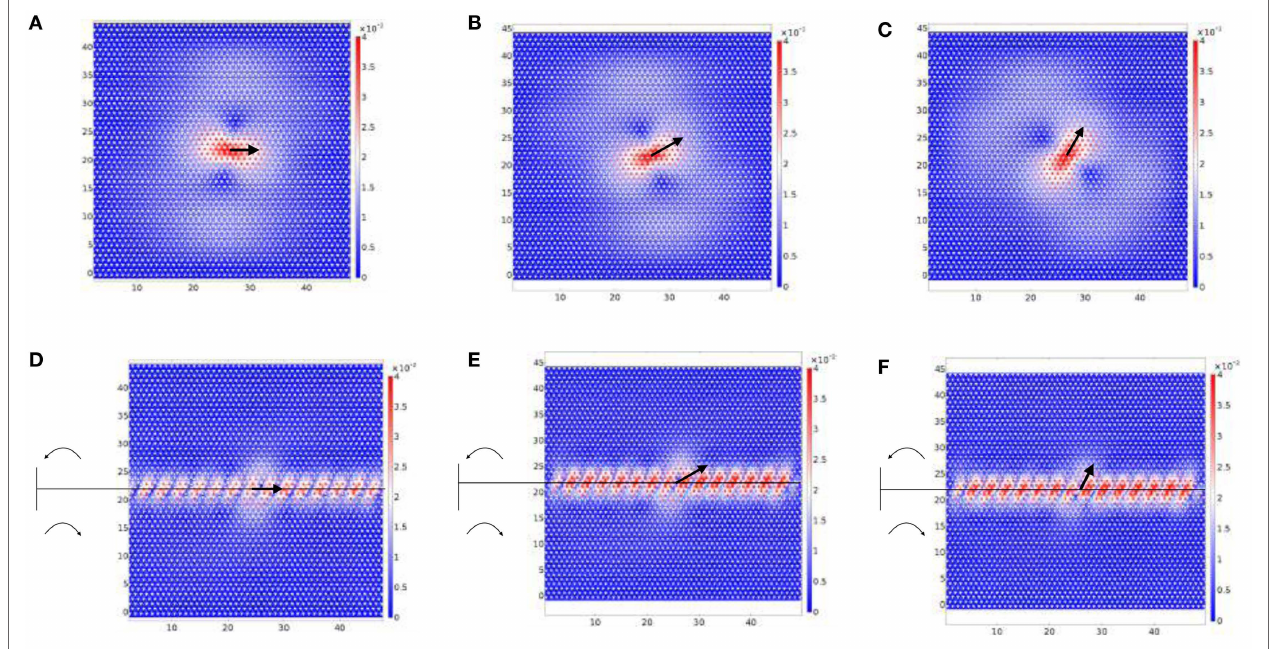
FIGURE 4 | Panels (A–C) are the responses of a homogeneous TLR to a harmonic force of amplitude F = 0.1N and frequency ω = π rad/s applied to a TL nodal point. The point loads (see black arrows) form an angle of 0, π /6, and π /3, respectively, with respect to the horizontal axis. Panels (D–F) are the responses of a non-homogeneous TLR to harmonic forces identical to those considered in panels (A–C) , respectively. The thin horizontal line marks the interface between anticlockwise tilting (upper part, ϑ 0 = (cid:0) 0.82rad) and clockwise tilting (lower part, ϑ 0 = 0.82rad). The lattice parameters used in all panels—the same as in Figure 3A —are given in the first row of Table 1